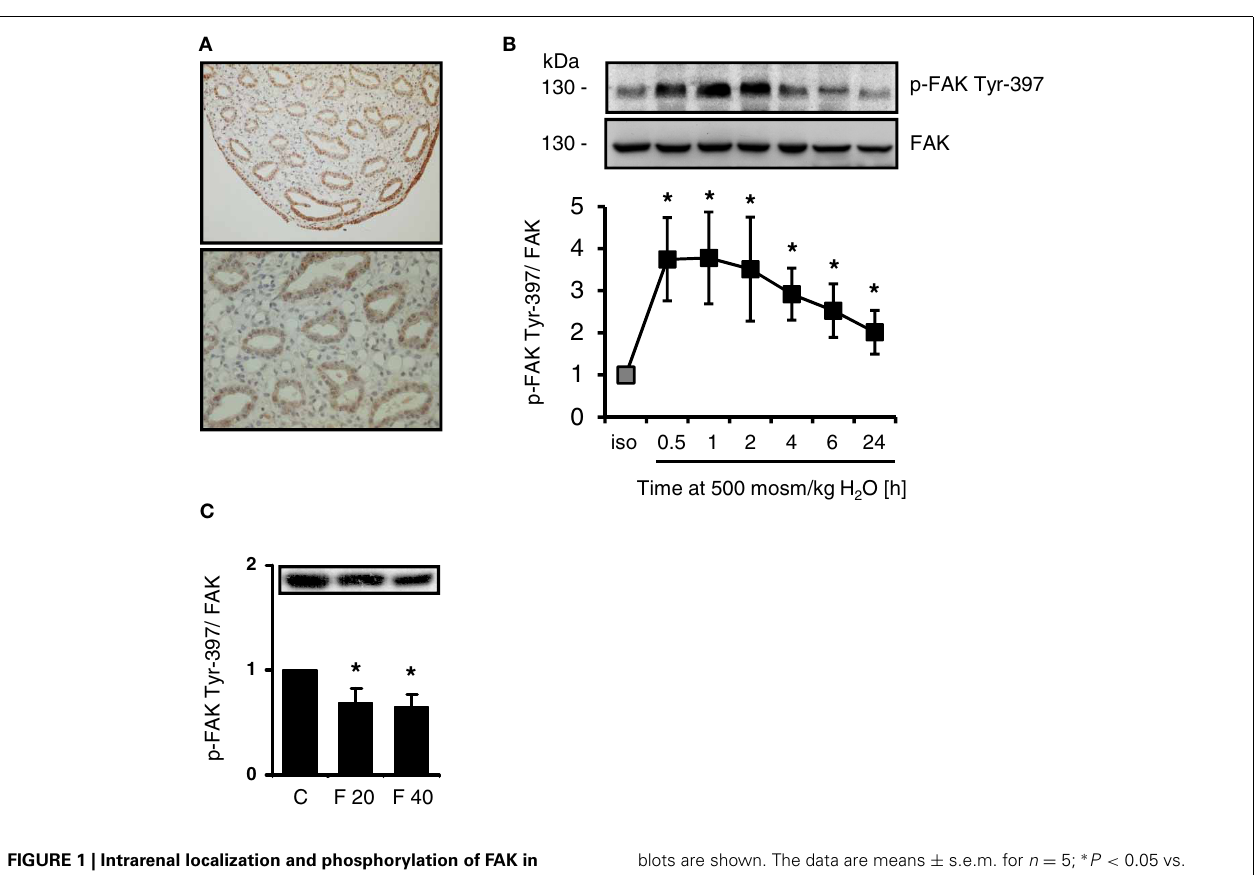
FIGURE 1 | Intrarenal localization and phosphorylation of FAK in response to osmotic stress. (A) Sections from normal rat kidney were immunostained for FAK as described in Methods. (B) HEK293 cells were incubated in hypertonic medium (500mosm/kg H 2 O) for the indicated periods. Subsequently, phosphorylation of FAK at Tyr-397 was determined by Western blot analysis and normalized to total FAK abundance. Representative